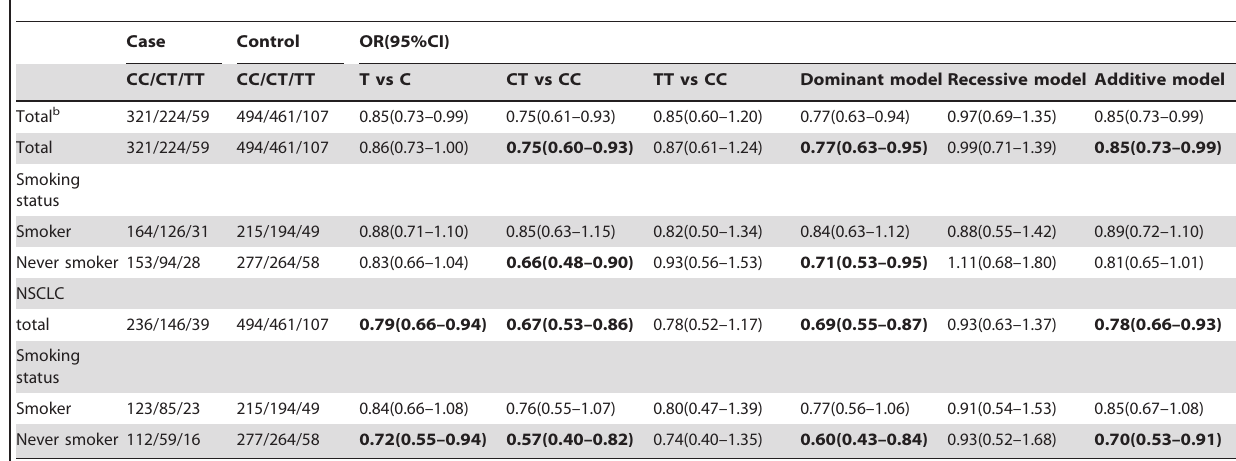
Table 2. Association between rs402710 and lung cancer risk in a Chinese population a .